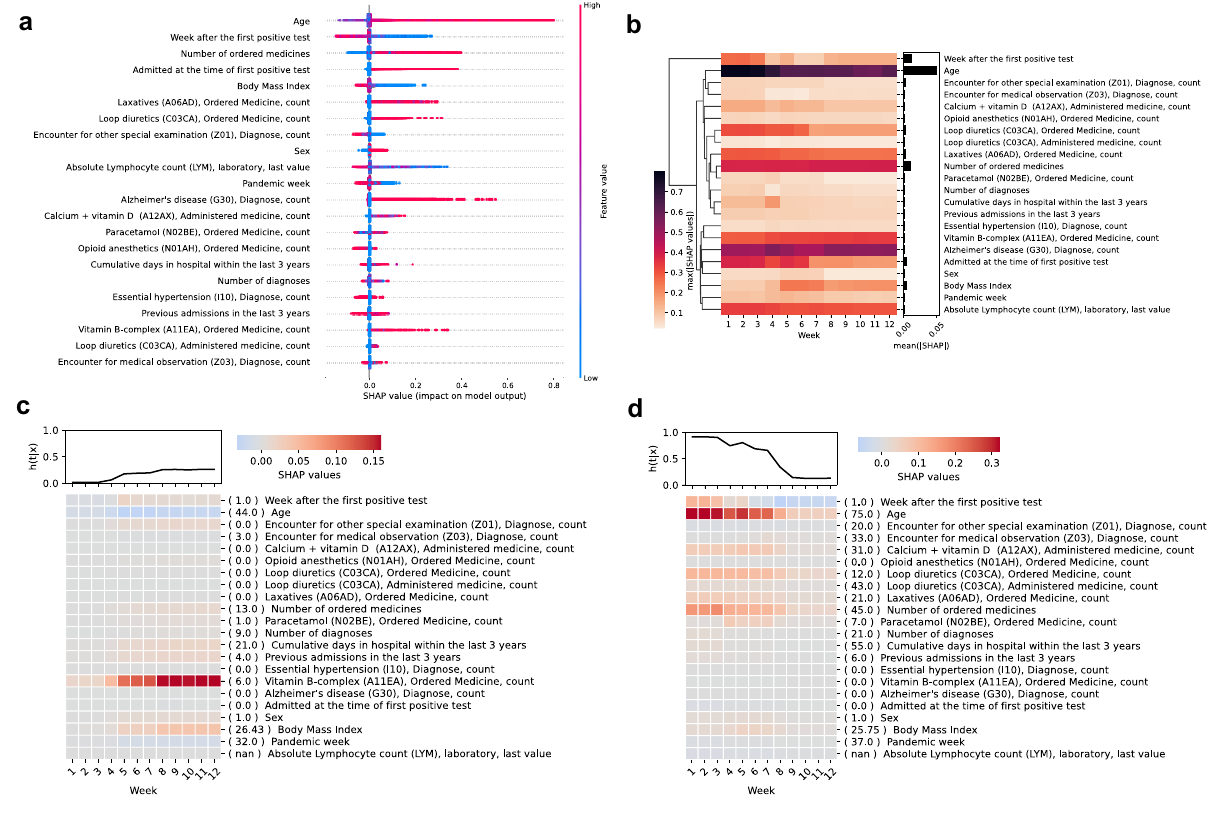
Figure 4. Global and local explanations of feature contributions to the risk of death in SARS-CoV-2 positive patients. SHAP values for each patient-week in the test set were calculated to explain the contribution of features to the discrete probability of death. A beeswarm plot ( a ) was generated to agglomerate all individual SHAP values for each patient-week with features coloured according to their normalised feature values. To explore the temporal dynamics, heatmaps were generated to show the maximum feature importance represented as the max(|SHAP|) across all patients ( b ) for each predicted week. The total feature importance of each feature was calculated as the mean(|SHAP|) across all weeks and shown as a bar plot ( b ). To exemplify personalized explanations, SHAP values for two patients ( c , d ) were depicted as heatmaps with their corresponding predicted discrete probabilities of death on top. The original feature values for each patient were reported inside round brackets next to the feature names. In all heatmaps, features were ordered by hierarchical clustering of the original feature values using Pearson correlation as the distance metric and average